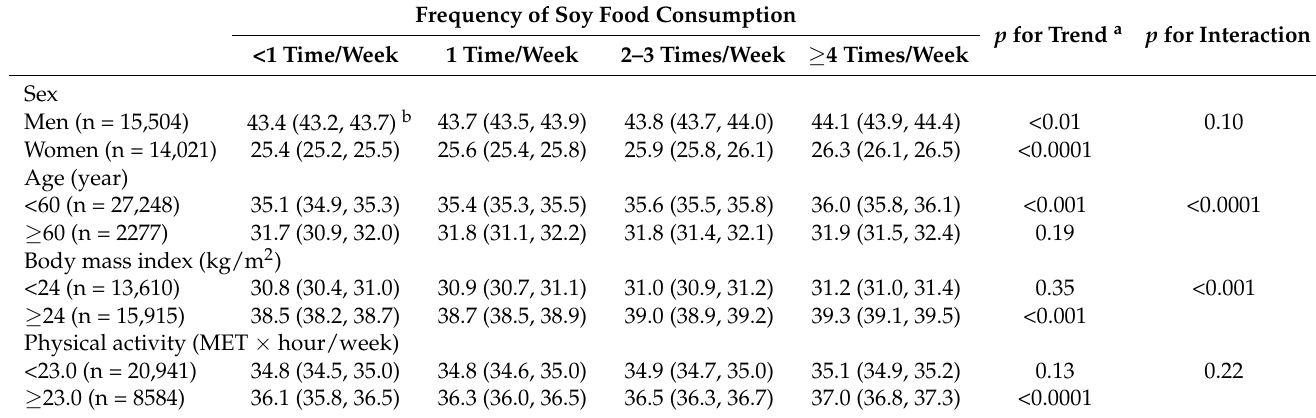
Table 3. Stratified analysis of associations between soy food intake and handgrip strength (n =